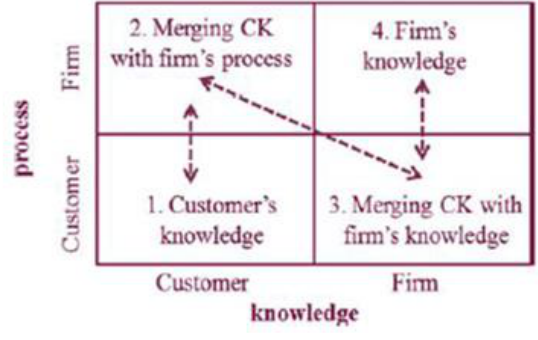
Fig. 2. Conversion of customers’ knowledge into firm’ knowledge (Taherparvar et al .,